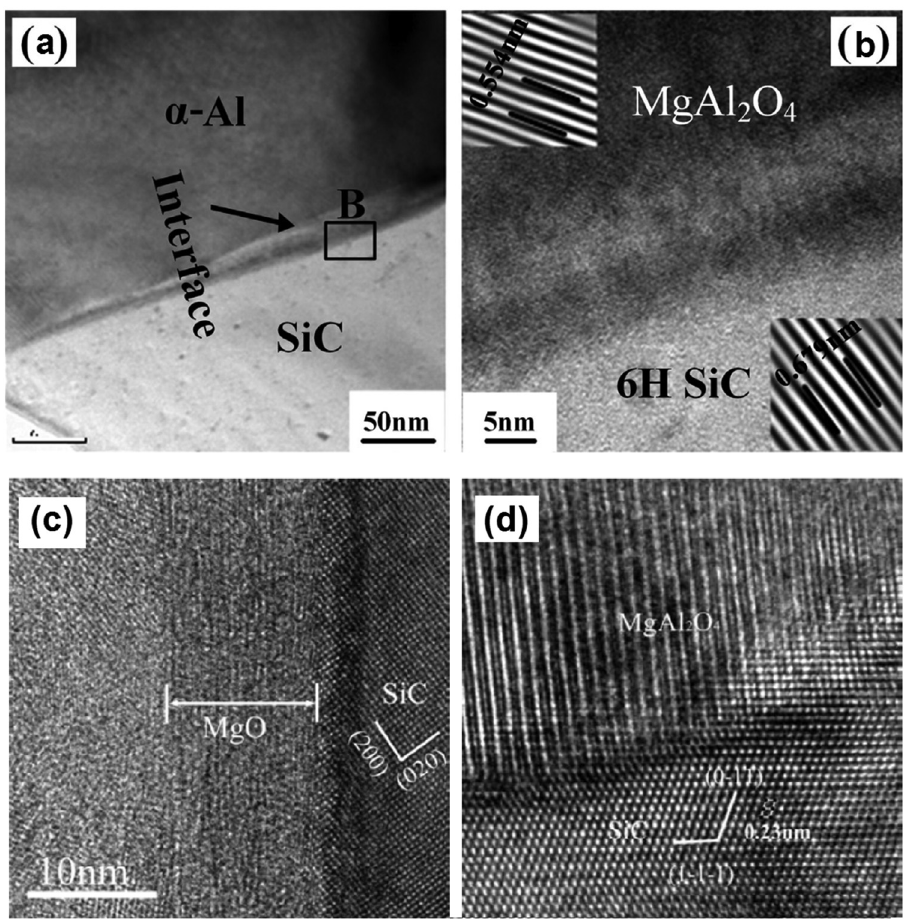
Figure 5: TEM images for pre - oxidized SiCp/Al – Cu – Mg - Si - Mn composites showing: ( a ) the SiC/MgAl 2 O 4 /Al interface and ( b ) HRTEM of the interface ( area B in subsection b ) ( Reproduced with permission from [ 107 ] . ) ( c and d ) HRTEM of the interfaces obtained for Al – Mg – Si/SiC composites after a solution heat treatment ( c ) , where MgO is obtained and overaged, ( d ) where MgAl 2 O 4 can be observed ( Reproduced with permission from [ 102 ] . )